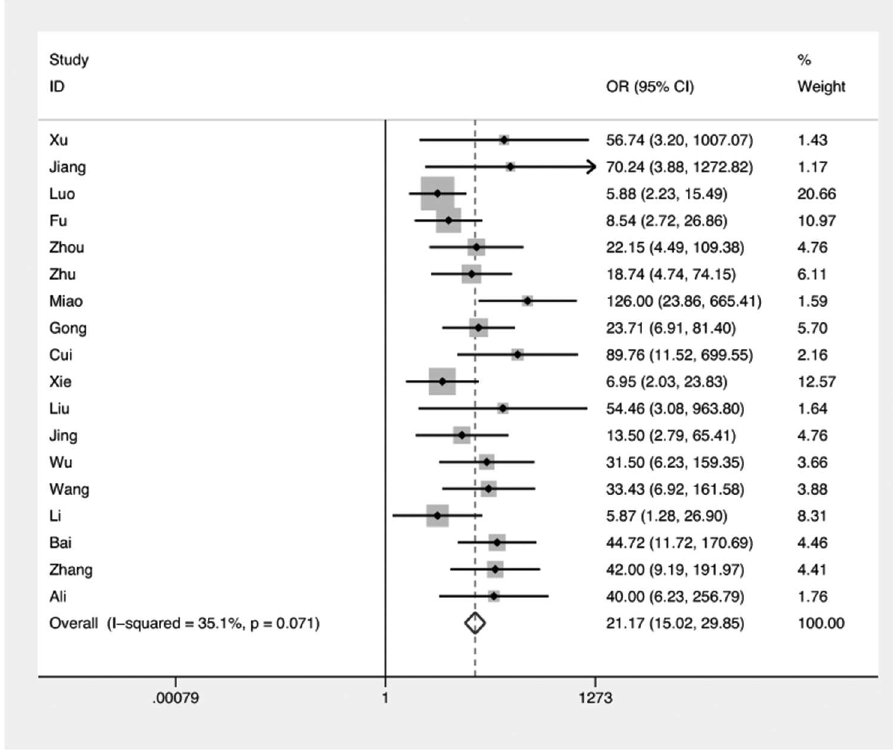
Fig 2. Forest plot: odds ratio (OR) for COX-2 expression in NPC and normal tissue.